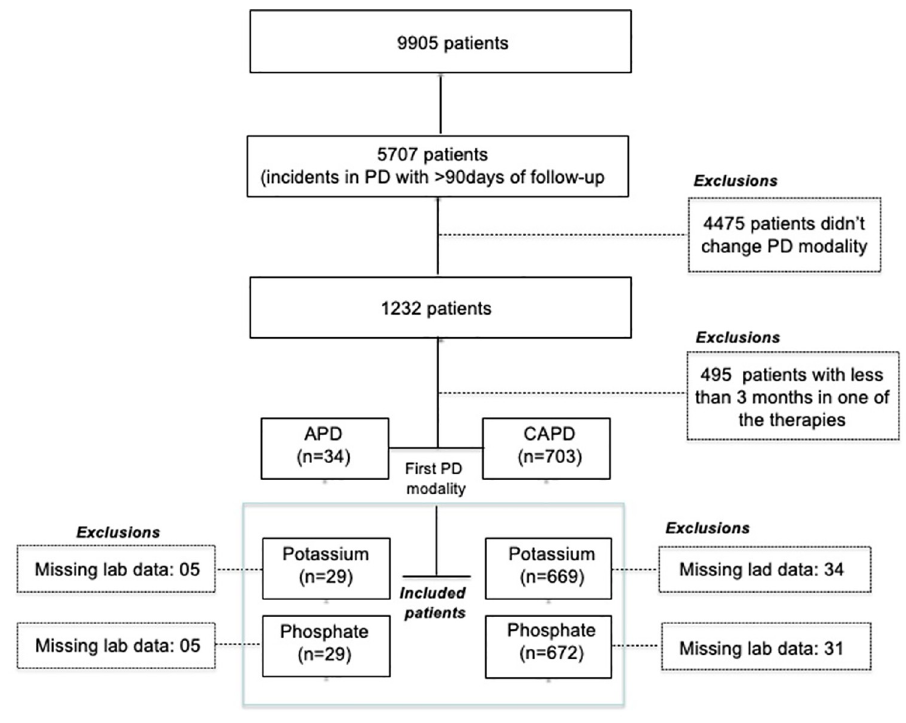
Fig 2. Study flowchart.